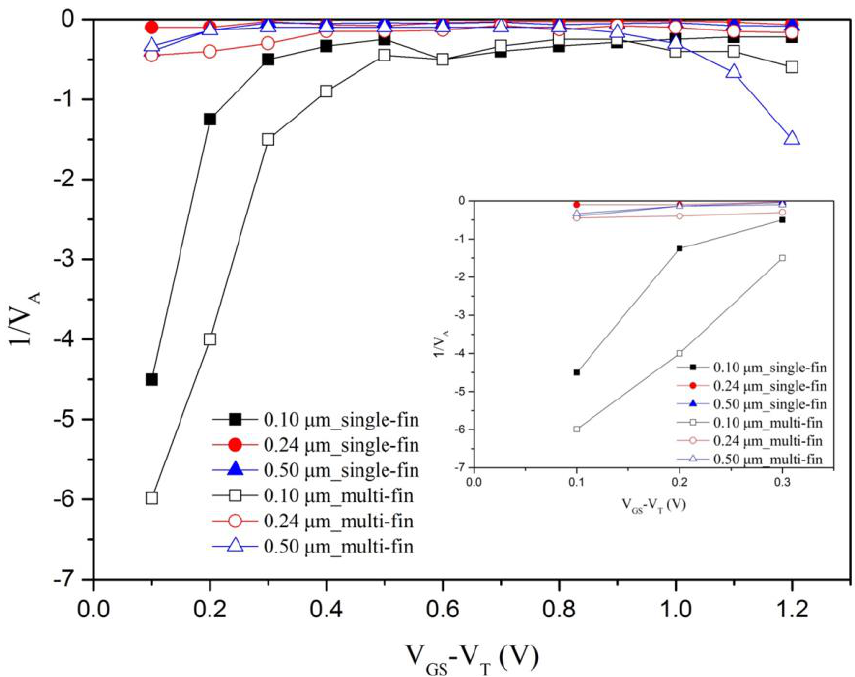
Figure 10. Distribution of ( V A ) − 1 vs. V GS – V T with single-fin and multi-fin. Inset: linear regression at